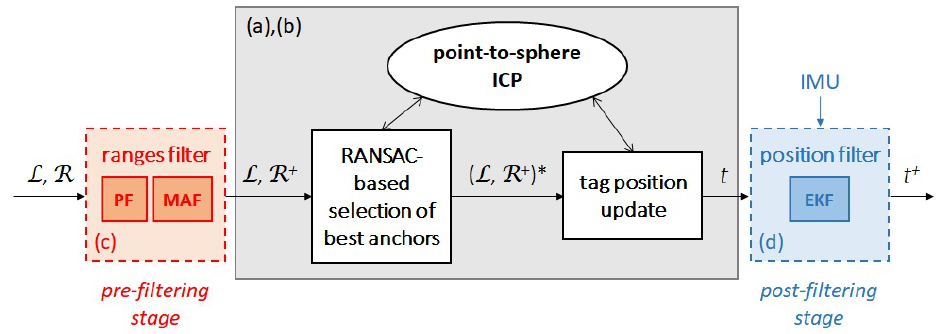
Figure 2. Block diagram of the full version of the ICP-based position estimation algorithm: L is the set of anchor locations, R is the set of ranges, R + is the set of filtered ranges, ( L , R + ) ∗ denotes the best set of anchors/ranges, t is the tag position, and t + is the filtered tag position. The dashed boxes used for the pre- and post-filtering stages denote that they can be removed. The gray box refers to the section that would be replaced by any of the methods overviewed in Section 5. ( a – d ) as defined in Section 3.